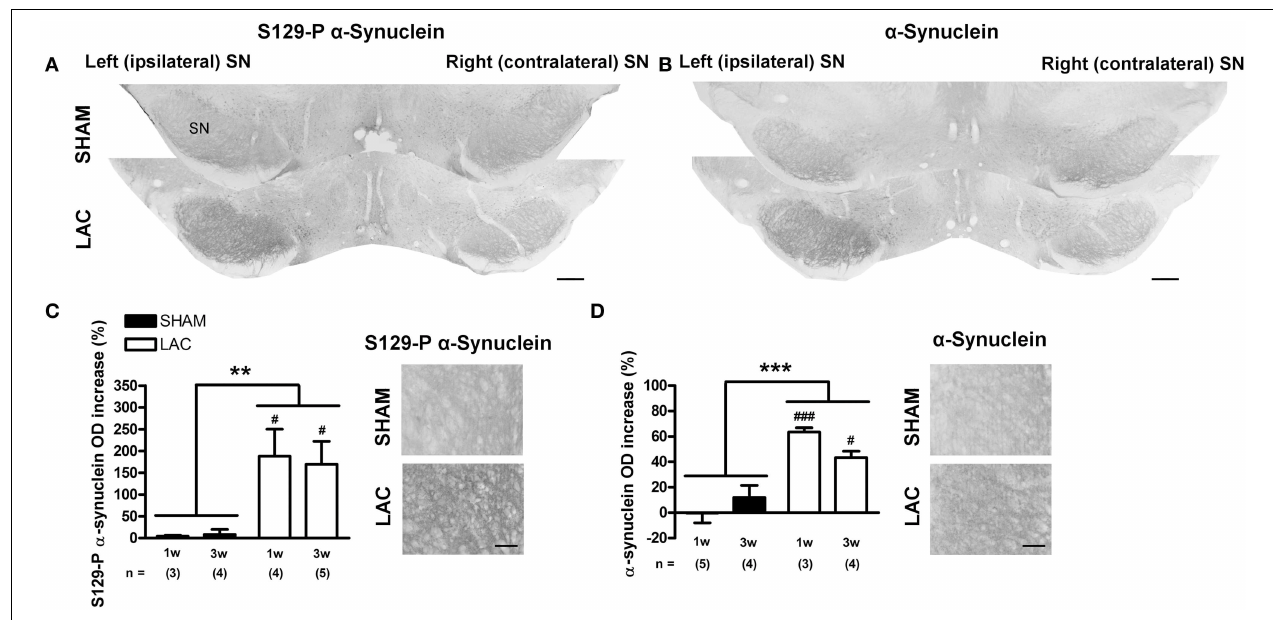
FIGURE 2 | Accumulation of α -synuclein and S129-P α -synuclein in the SN of mice receiving 3 µ g LAC. Immunohistochemical analyses revealed an increase in S129-P α -synuclein (A,C) and α -synuclein (B,D) immunoreactivity in the SN of LAC-treated mice. High magnification photomicrographs of the ipsilateral SNr in (A,B) demonstrate the presence of S129-P α -synuclein and α -synuclein immunoreactive fibers ( C,D respectively). Data are presented as